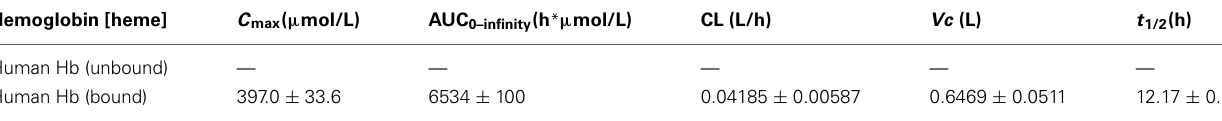
Table 4 | Pharmacokinetic parameters Hb bound to multimeric Hp (mean ± SEM) following prednisone treatment in Beagles. Hemoglobin [heme]